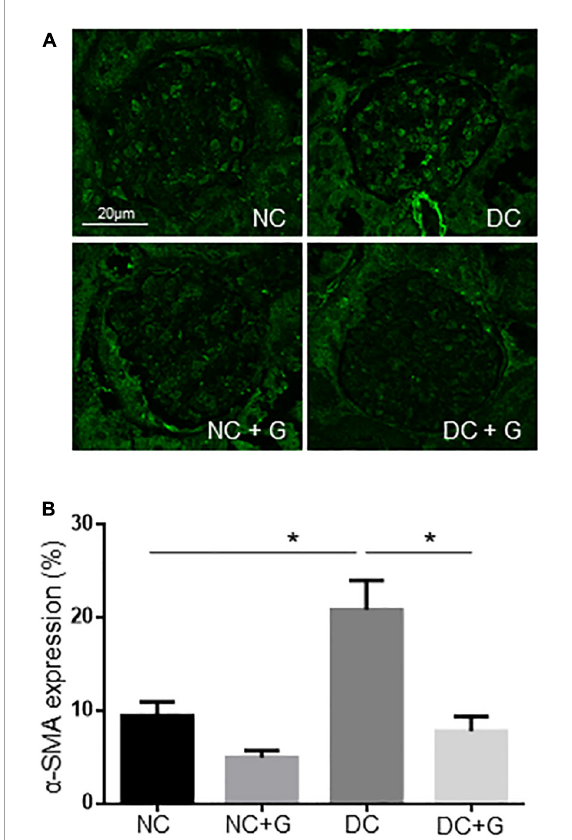
FIGURE5 Glucosamine decreases α -SMA expression in the diabetic glomeruli. (A) Representative images show α -SMA expression detected by immunofluorescence staining. (B) Quantification of α -SMA expression was normalized by the glomerular areas from analyzing 20 glomeruli each kidney. The experiments were repeated in 3 kidneys each group. Data are shown in mean ± SEM. n = 20. * p <